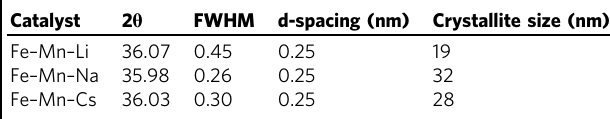
Table 3 Crystallite size of the various prepared catalysts (different base metal) with citric acid method.